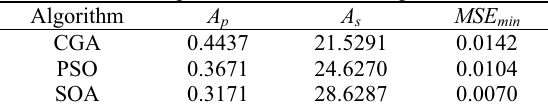
Table 3. The performances of three digital filters